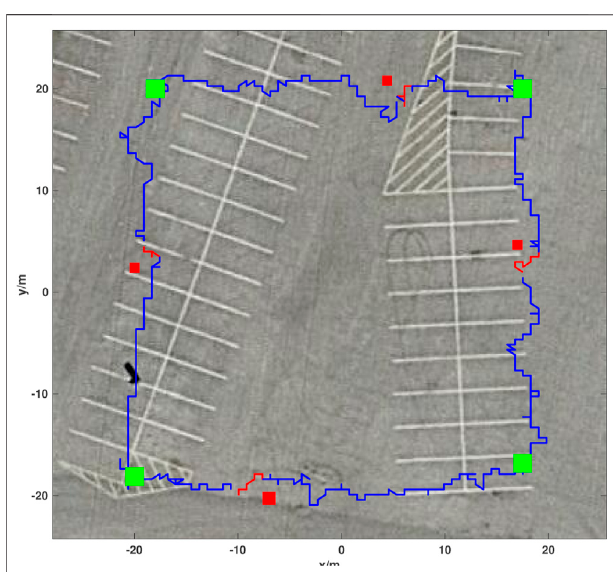
FIGURE 5 | Real-world AGV obstacle avoidance mission showing mission waypoints as green squares, placed obstacles as red squares, DRL agent augmented paths for avoidance in red, and the vehicle trajectory followingthemissionpathinblue.Thesamplemissionshowntook250 s and covered 120 m. The mission trajectory starts at the bottom left mission waypoint and progresses